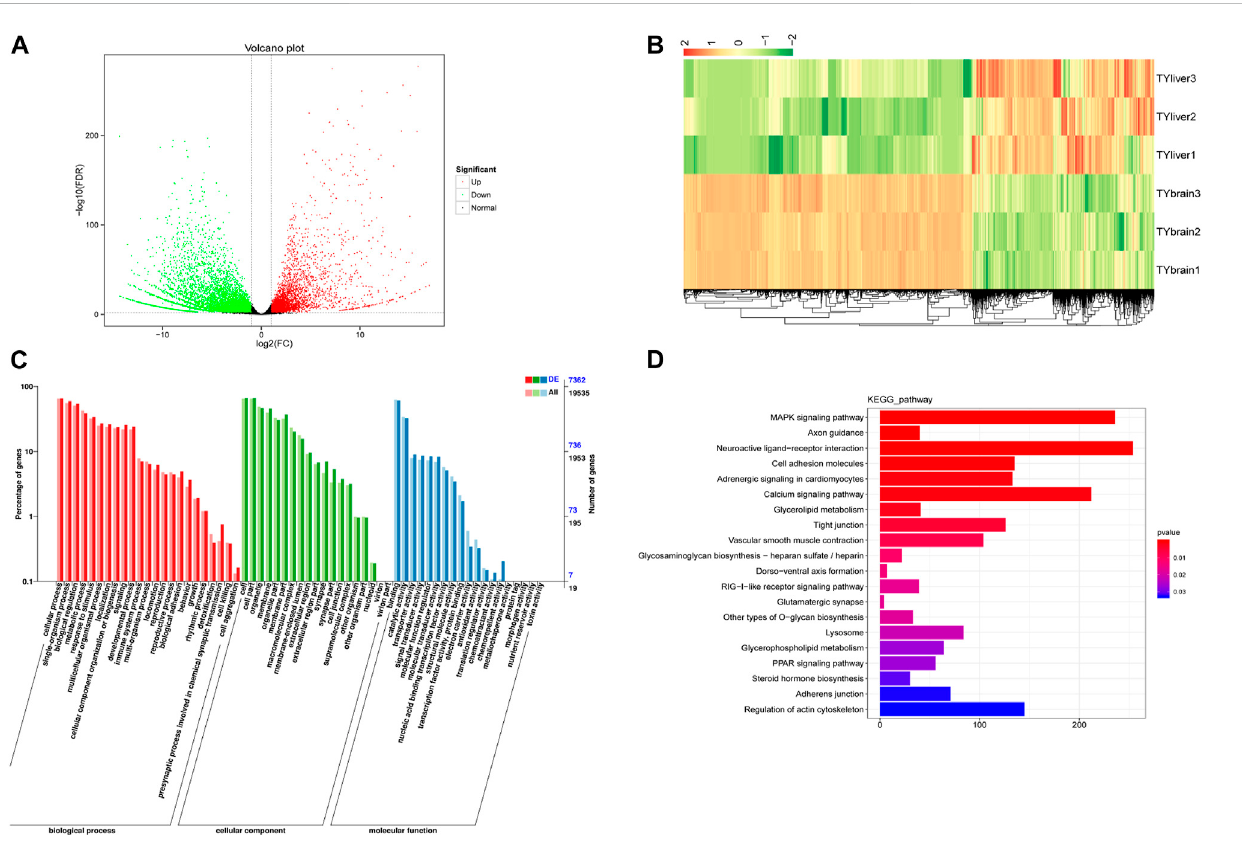
FIGURE 2 Differentially expressed genes (DEGs) analysis between brain and liver of T. yarkandensis . (A) Volcano plot of DEGs between brain and liver. Each point represents a gene. The green and red dots in the fi gure represent signi fi cantly differentially expressed genes, with green representing down-regulated gene expression, red representing up-regulated gene expression, and black dots represents a gene with no signi fi cant difference in expression. (B) Hierarchical clustering analysis was performed on the DEGs between brain and liver. The color represents log 2 (FC). (C) GO classi fi cation of DEGs between brain and liver. (D) KEGG enrichment of DEGs between brain and liver.